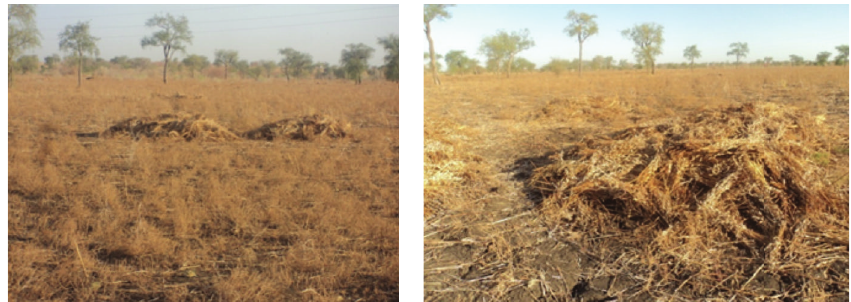
Figure 1: Sesame stalk left at the farms (pictures taken on